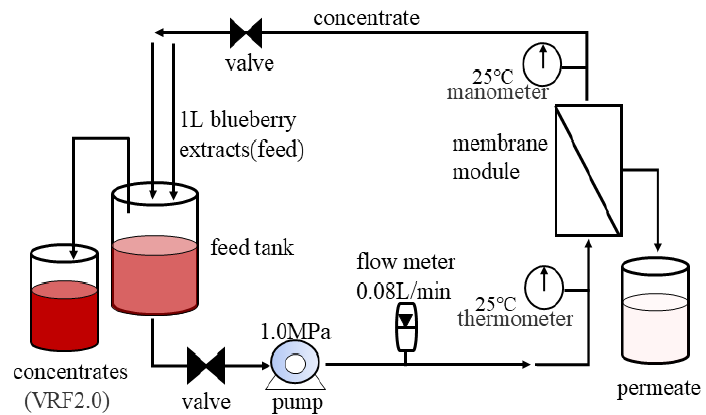
Figure 1. Schematic diagram of the NF system.